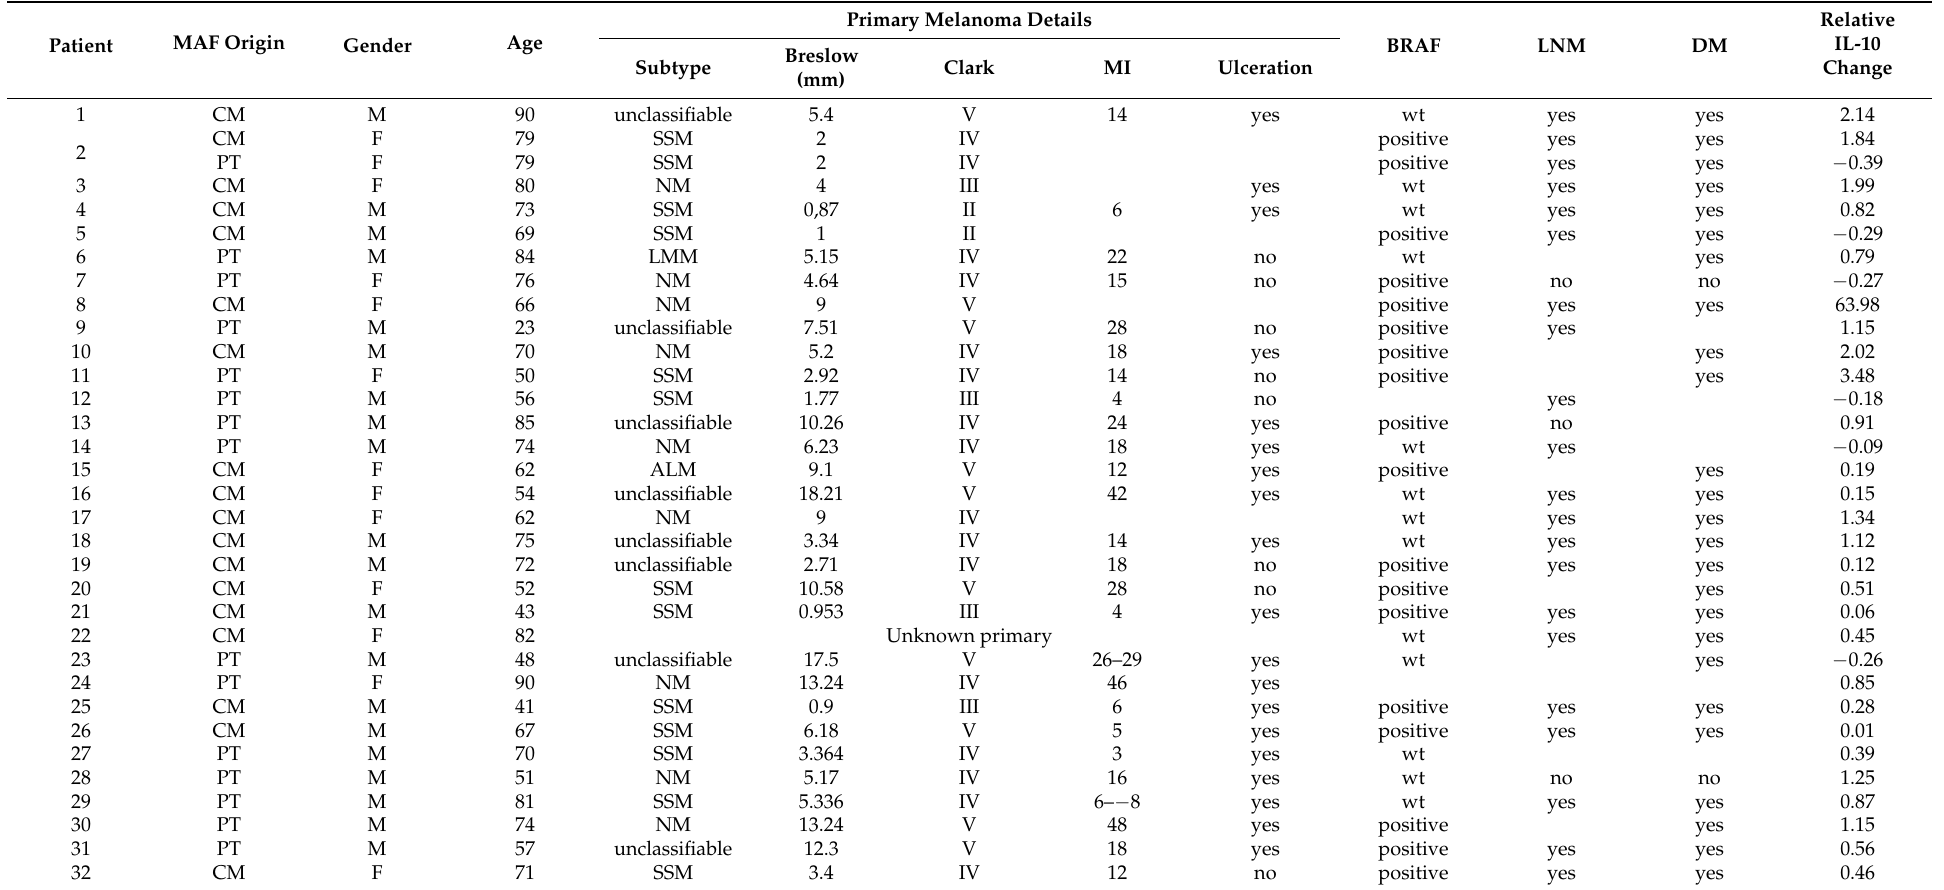
Table 1. Clinicopathological properties of MAF isolated patients and relative IL-10 concentration difference of MAF macrophage co-culture from macrophage monoculture. ALM: acral lentiginous melanoma, CM: cutaneous metastasis, DM: distant metastasis, F: female, LMM: lentigo maligna melanoma, LNM: lymph node metastasis, M: male, MI: mitosis index, NM: nodular melanoma, PT: primary tumor, SSM: superficial spreading melanoma, wt: